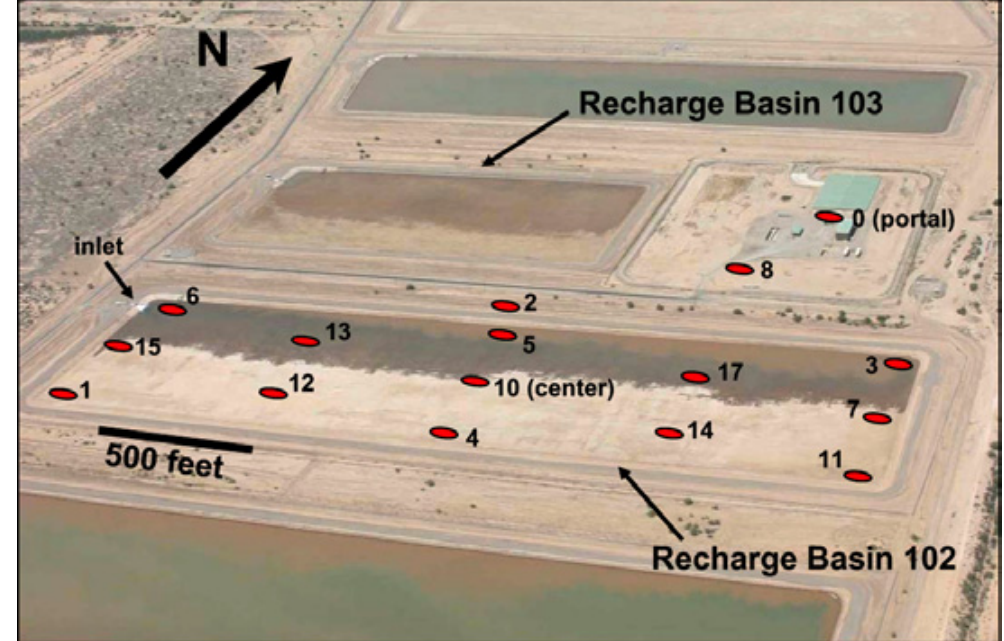
Figure 4. Aerial view of a portion of CAVSARP facility showing the location of the Sensor Web pods in recharge basin 102. The portal pod (pod 0) is connected to a computer which transfers the data to the Internet. In this photograph, recharge basin 103 is drying out, with the wetter soil in the northern portion of the basin. In contrast, basin 102 is being flooded with the moving water advancing southward. The basins immediately north of 103 and south of 102 are fully flooded.